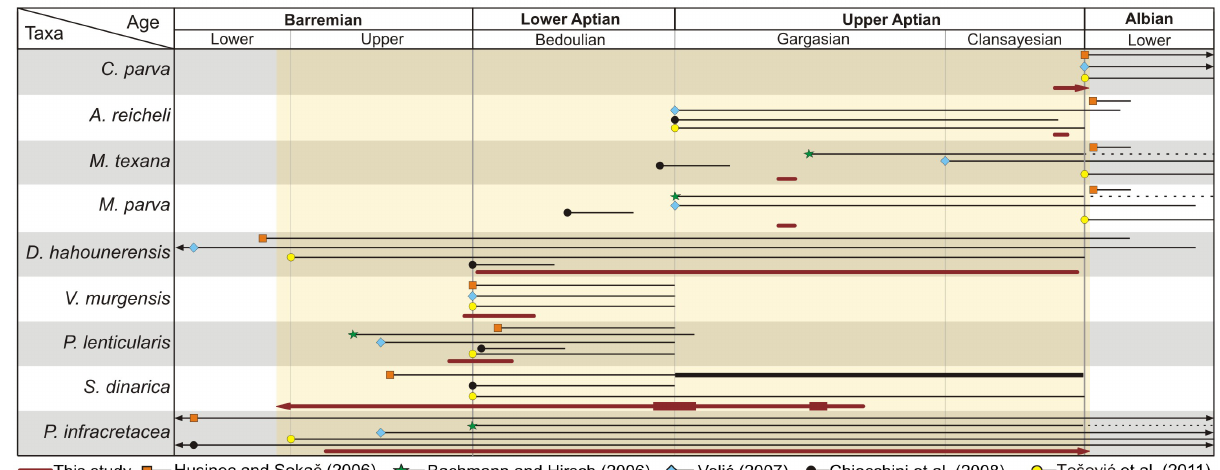
Fig. 16. Chronostratigraphic calibration of the Apenninic carbonate platform biostratigraphy. The calibration is based on the chemostrati- graphic correlation with well-dated basinal sections (see Fig. 15). The chronostratigraphic calibration of the same biostratigraphic events, proposed by previous works on the Apenninic and other central and southern Tethyan carbonate platforms, is given for comparison. The shaded field indicates the chronostratigraphic interval covered by the sections studied in this